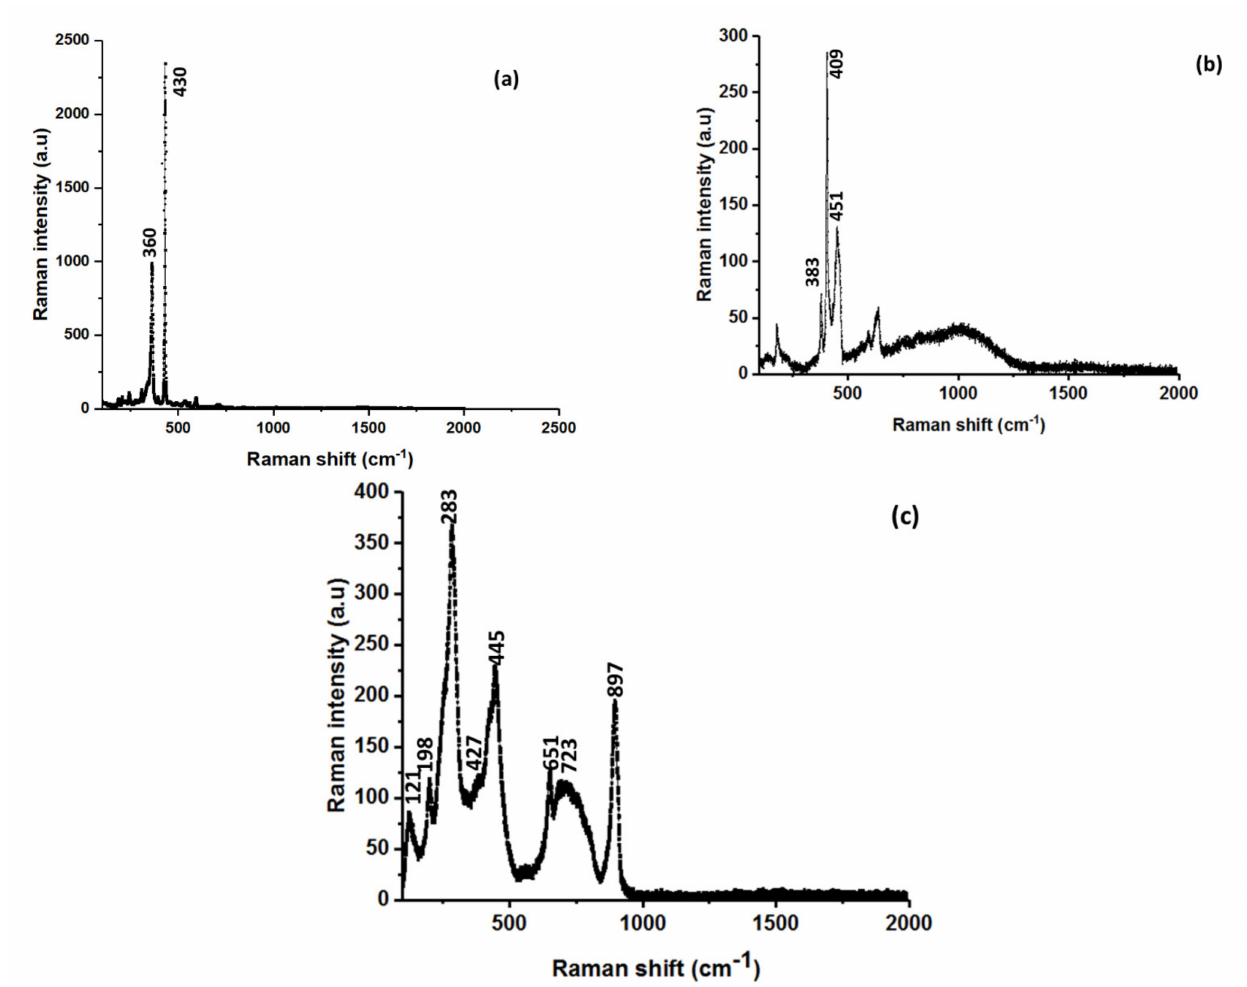
Figure 1. ( a ) Raman spectra of WS 2 ; ( b ) Raman spectra of MoS 2 (383, 409 cm − 1 ) (Mo1); ( c ) Raman spectra of PT.